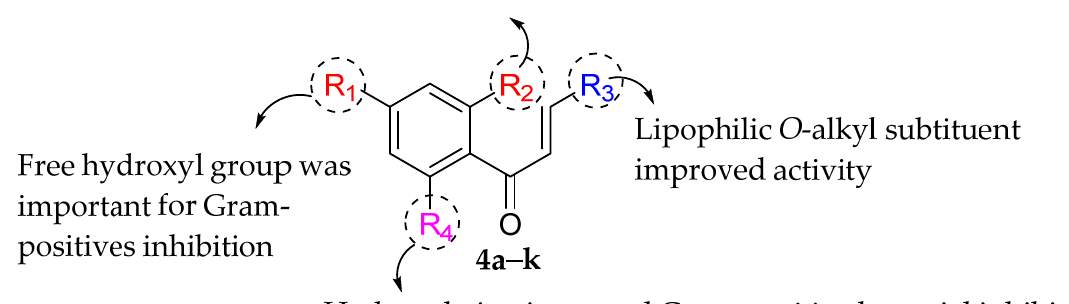
Figure 16. The chemical structure and SAR of chalcones tested [82].